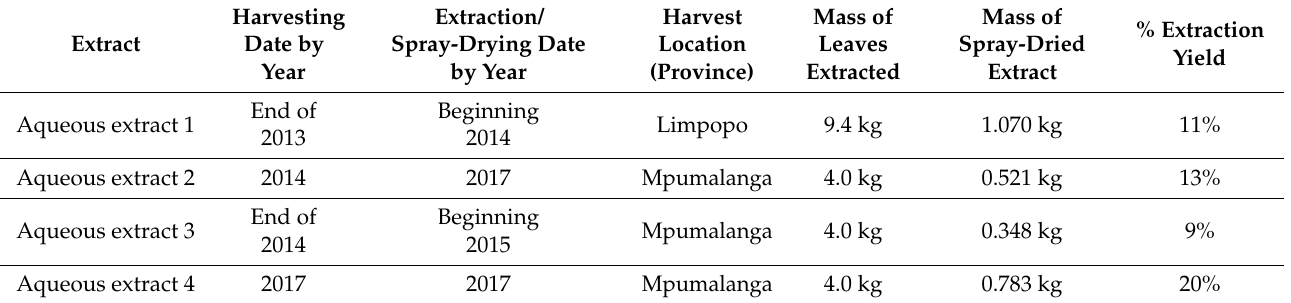
Table 1. Plant harvesting, extraction, spray-drying and yields of Sclerocarya birrea (Marula)